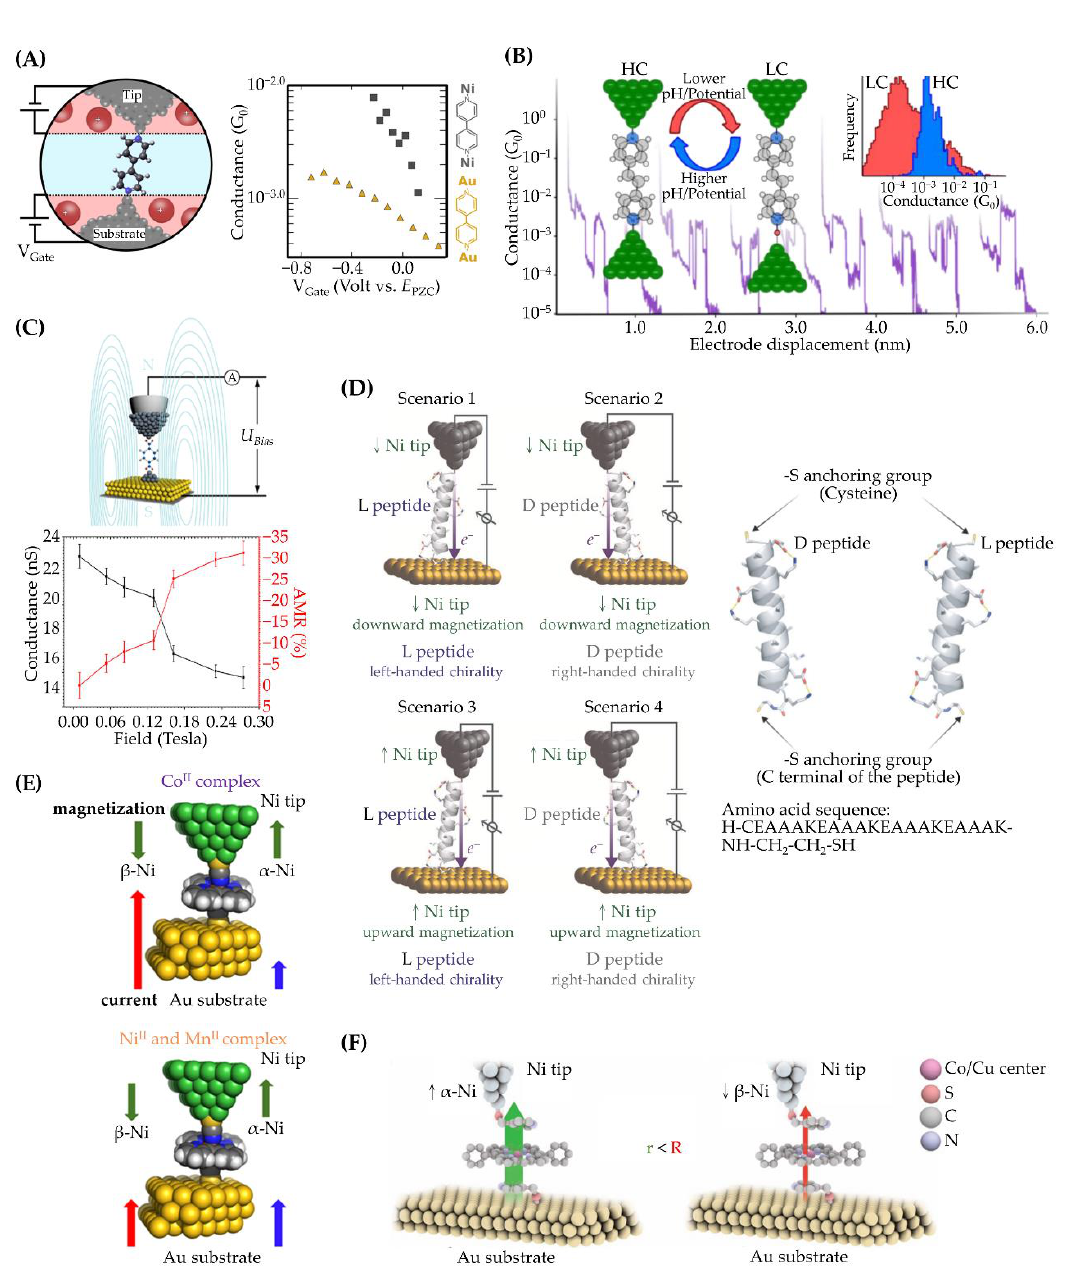
Figure 5. Schematic illustrations of representative research on investigating single-molecule conductance on magnetic electrodes. Electrodes: ( A ) Ni and Au; ( B ) Ni; ( C ) Fe clusters prepared with the approach of jump-to-contact EC-STM; ( D – F ) a pair of a Ni tip and Au substrate. ( A ) A 4,4-bipyridine junction under electrochemical control. The applied V Gate is plotted against the potential of zero charge (PZC) of the Ni and Au substrates, which was −0.87 V or +0.13 V versus a saturate calomel electrode (SCE), respectively. The molecular conductance on Ni electrodes was found to be higher than that on Au electrodes. ( B ) Two sets of conductance histograms for 4,4′-vinylenedipyridine. In addition to the applied electrochemical potential, the junction conductance is sensitive to the solution acidity, which is ascribed to protonation/deprotonation of vinylenedipyridine. ( C ) Con- ductance measurement of terephthalic acid with electrodes of Fe clusters. The dependence of the junction conductance on the external magnetic field shows the behavior of anisotropic magnetoresis- tance. ( D ) Illustration of spin-polarized transport regulated by α -helical peptides with two isomeric forms: dextrorotatory (D-) and levorotatory (L-). With the same bias direction, the four scenarios of arrangements confer the descendant order in conductance of 1 > 4 > 3 > 2. ( E ) EME